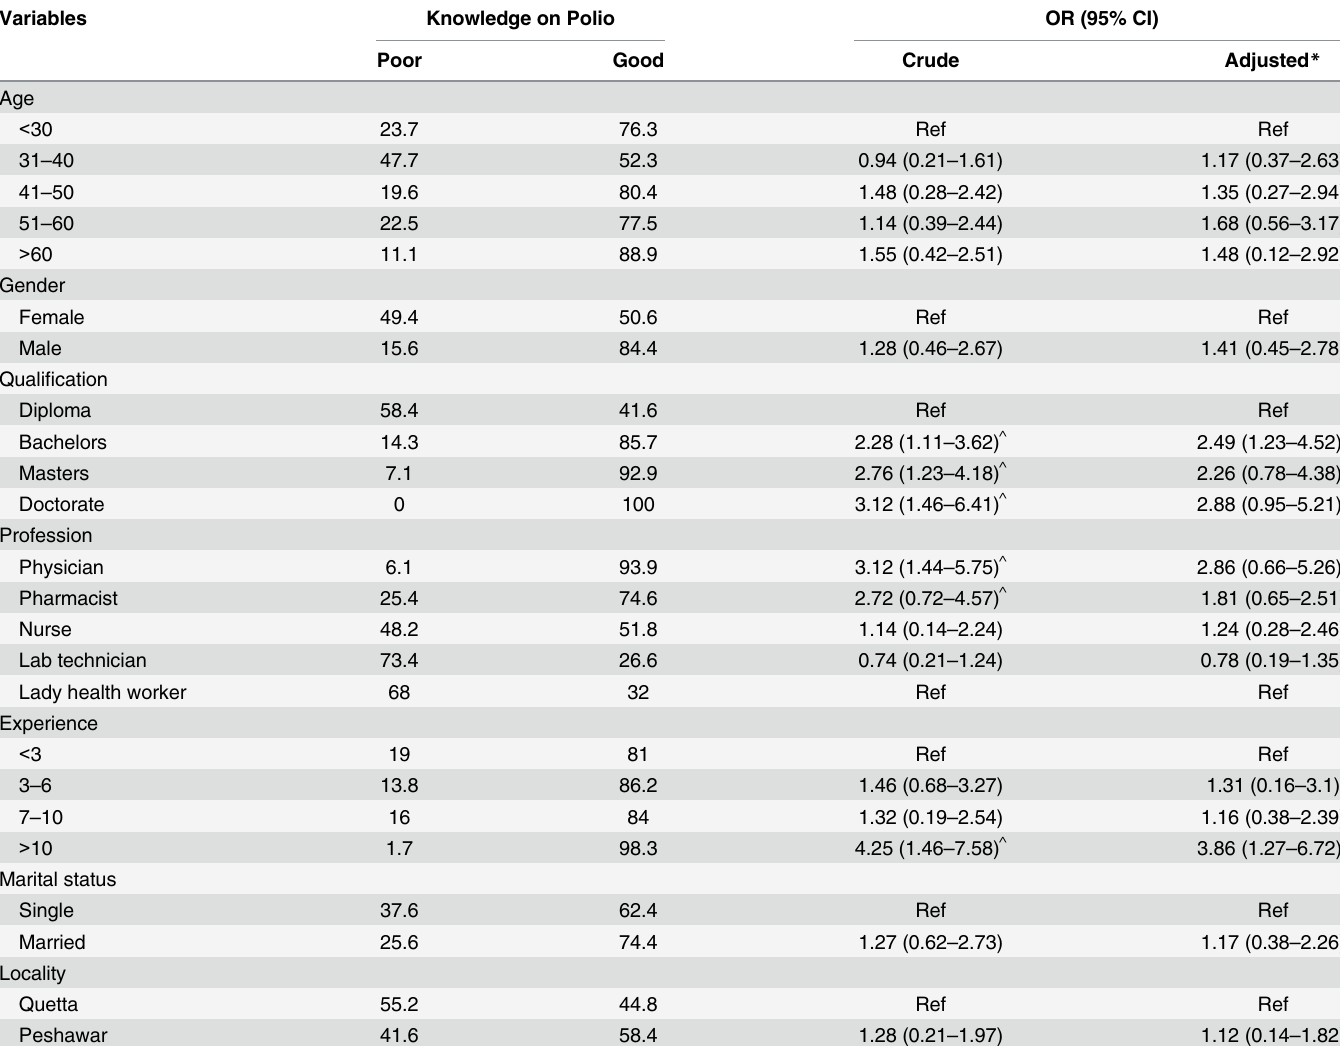
Table 3. Correlates of knowledge on polio with demographic variables among healthcare workers Peshawar and